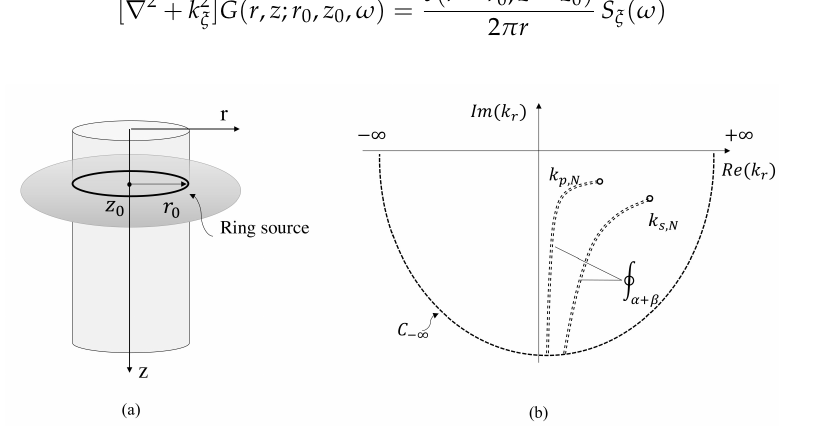
Figure 6. ( a ) Representation of the ring source in cylindrical coordinates; and ( b ) complex wavenumber plane and definition of the Ewing–Jardetsky–Press (EJP) branch